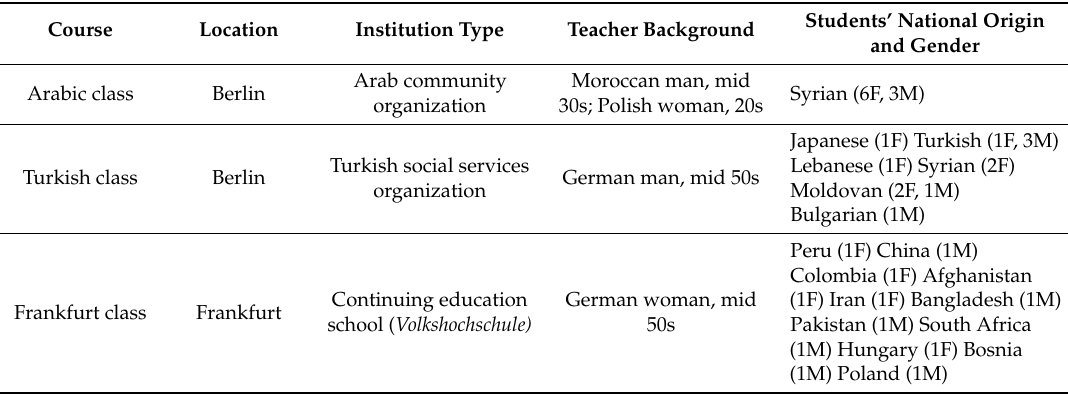
Table 1. Description of Integration Courses